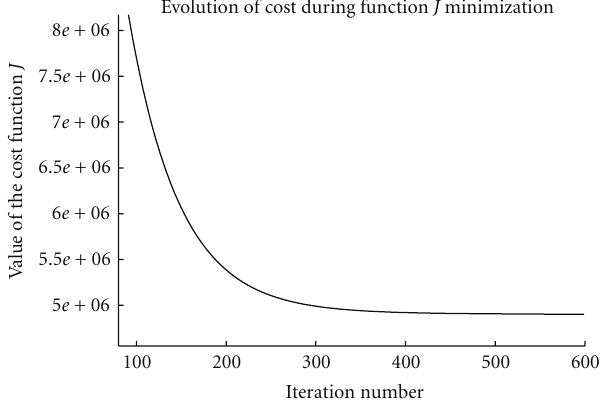
Figure 3: Evolution of the cost function J along the iterations of the gradient descent process for an image restoration.